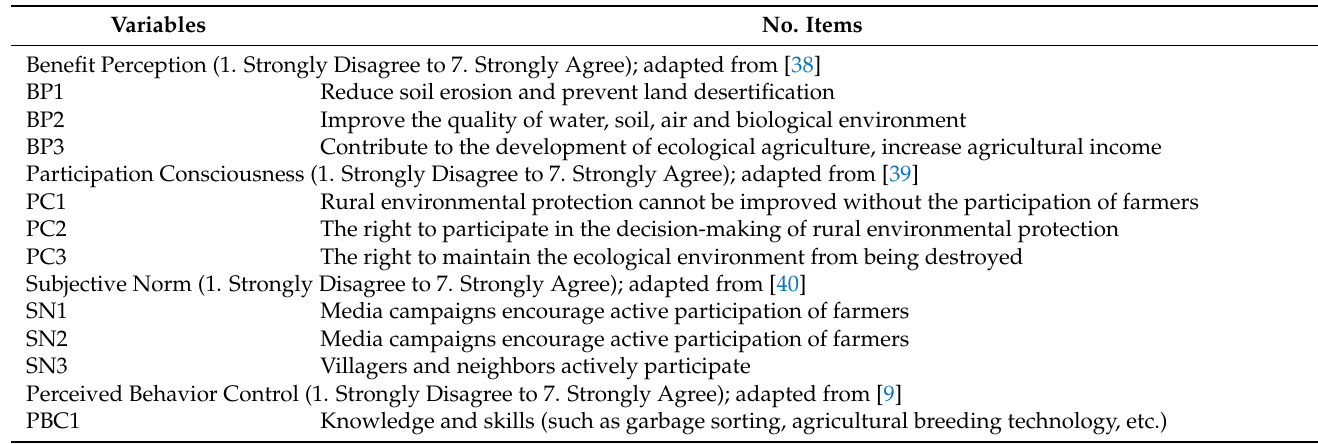
Table A1. Survey